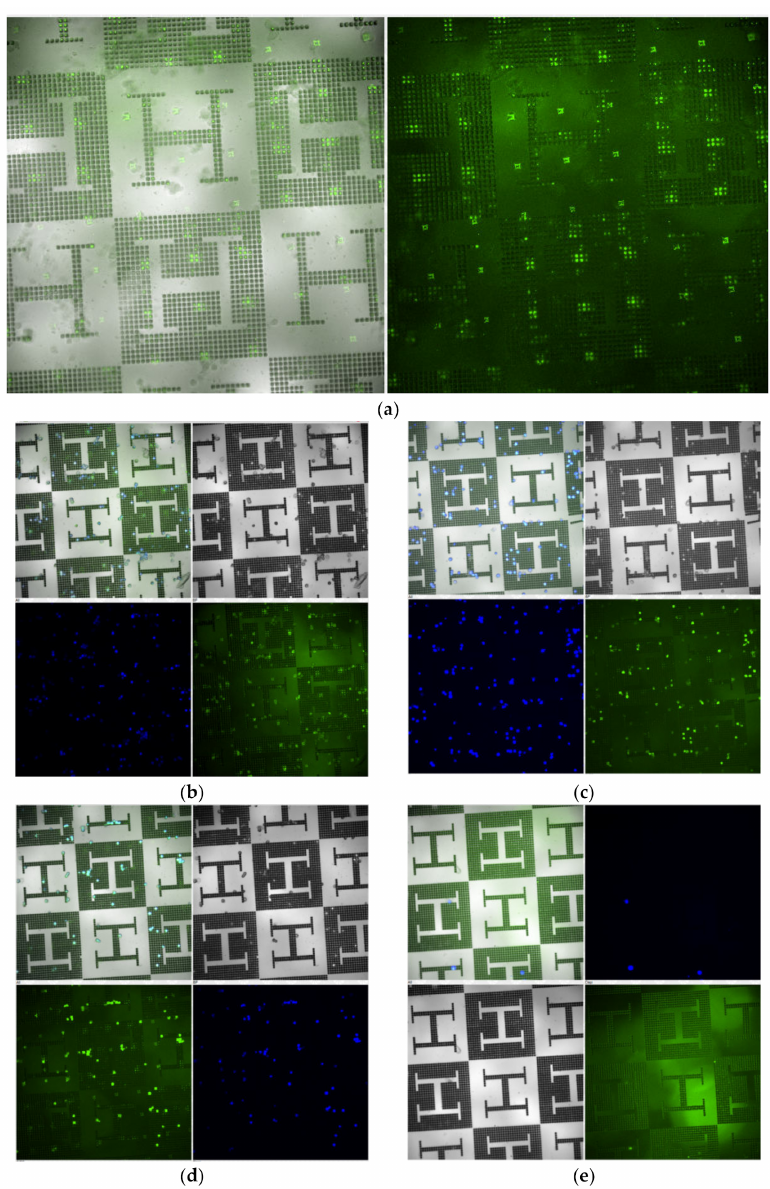
Figure 5. ( a ) Fibronectin functionalization obtained by polymer pen lithography (PPL) shown as a pattern of green dots / squares. ( b , c , d ) Cell culture results on fibronectin-functionalized PMMA replicas. ( e ) Cell culture results on non-functionalized PMMA replicas. Fluorescent microscopy: DAPI (blue) shows cell nuclei, fibronectin (green) is indicating where the adhesion pattern is printed. The scale bar is 100 µ